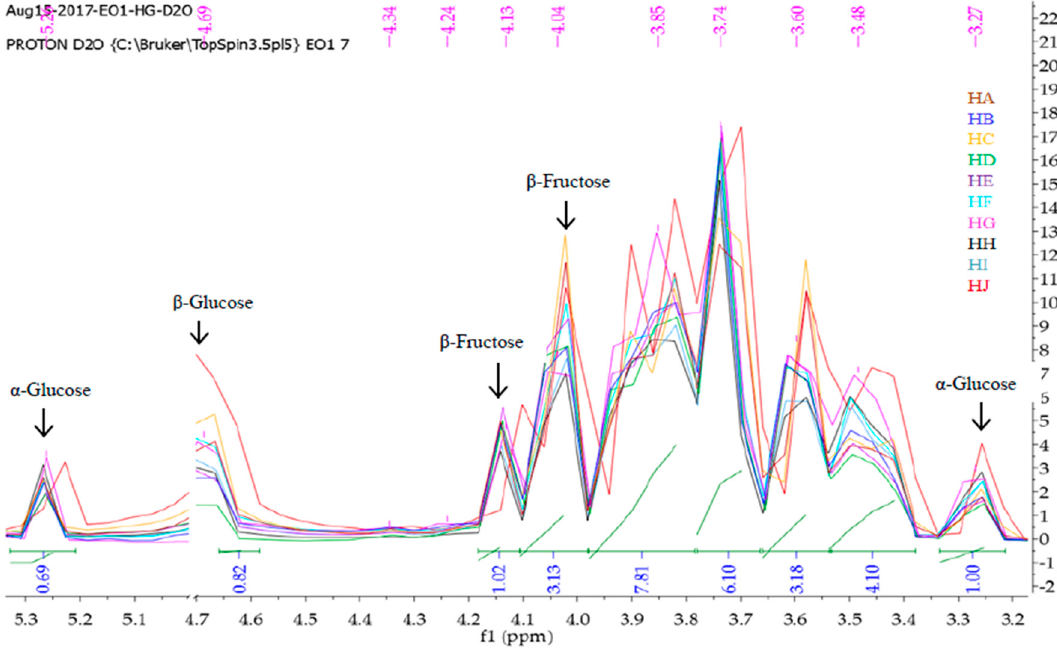
Figure 4. Fingerprints of superimposed and binned 1 H-NMR spectra in D 2 O at region 5.30–3.20 ppm, using Mnova 12 NMR software.